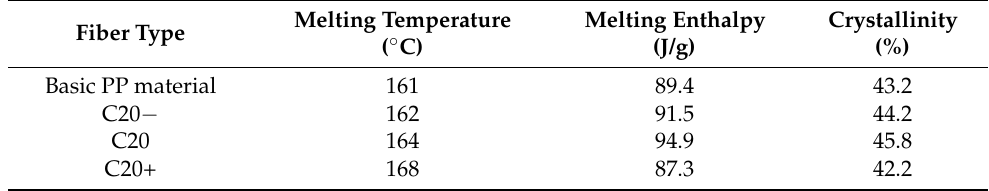
Table 6. DSC evaluation of C20 − , C20, and C20+ fibers in comparison to the basic PP